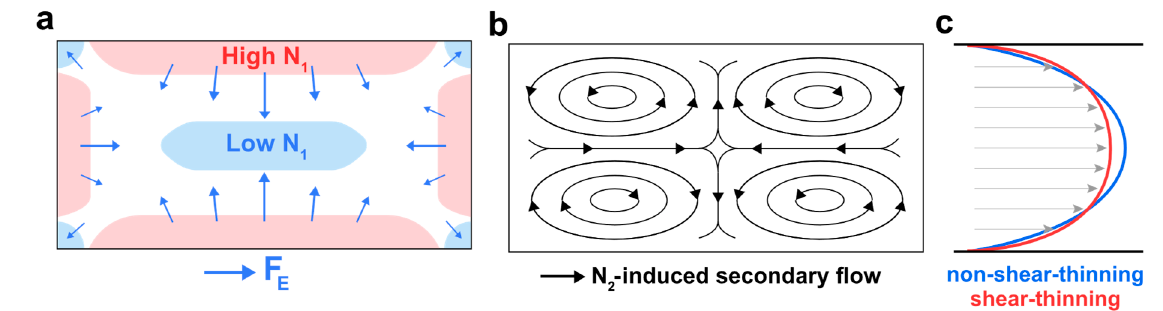
Figure 1. Schematics of the viscoelastic phenomenon in a rectangular channel flow of Giesekus fluid. ( a ) First normal stress difference (N 1 ) distribution in the cross-section; Elastic force drives particles towards the lowest N 1 regions. ( b ) Elasticity-induced secondary flow due to the presence of the non-zero second normal stress difference (N 2 ). ( c ) Comparison between the velocity profile in non- shear-thinning fluids ( Newtonian , Oldroyd-B , etc.) and the warped velocity profile in shear-thinning fluids ( Giesekus , etc.). Table 1. Selected existing studies on the focusing and separation of particles in viscoelastic fluid. Approach Fluid Type Flow Regime Geometry Considered in Simulations Reference Exp. Sim. Shear-Thinning Secondary Used in Exp.